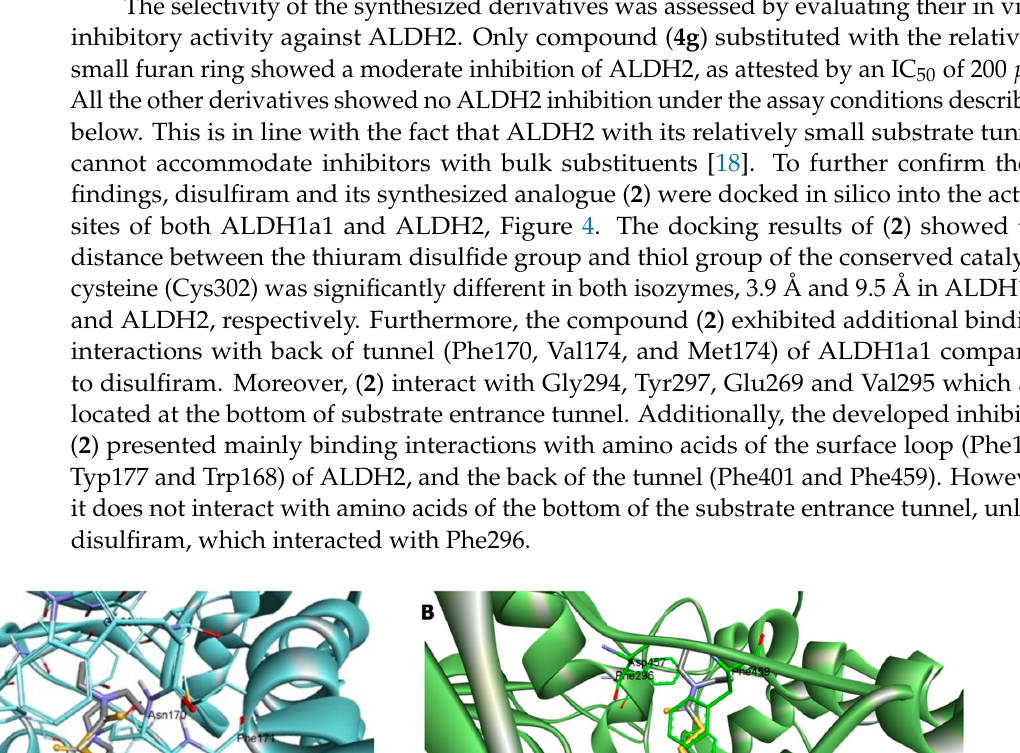
Solvents (EtOH, DCM, MeOH, DMF, chloroforme, toluene, and water), minerals (MgSO 4 and CaCl 2 ) were purchased from Carlo Erba Reagents (Dacit Group). All other chemicals were mainly purchased from Alfa Aesar (Karlsruhe, Germany), Merck (Sigma Aldrich) and TCI Europe (Boerenveldseweg, Belgium) or other commercial sources and used without further purification. Analytical thin layer chromatography (TLC) was per- formed with Nacherey Nagel (Polygram SILG/UV254) plates. Compounds were visual- ized by exposure to UV light or by dipping the plates in solutions of ninhydrin or potas- sium permanganate followed by heating. Flash column chromatography was performed with silica gel 60 (Acros Organics, Belgium). NMR spectra were recorded on BRUKER Avance III 400 MHz spectrometer in the indicated solvent. 1 H-and 13 C-NMR chemical shifts ( δ ) are quoted in parts per million (ppm) relative to the TMS scale. Coupling con- stants J are quoted in Hz. The following abbreviations are used for the proton spectra multiplicities: s: singlet, d: doublet, t: triplet, q: quartet, qt: quintuplet, sp: septuplet, m: multiplet, br.: broad, dd: double doublet, dt: double triplet. Coupling constants ( J ) are re- ported in Hertz (Hz). Infrared spectra were run on a Shimadzu IR Affinity spectropho- tometer coupled to a diamond ATR. High Resolution Mass Spectrometry (HRMS) was carried out on a Waters LCT Premier Time of Flight mass spectrometer using a Waters Acquity BEH C18 column (50 mm × 2.1 mm, 1.7 μ m). HPLC separation was performed at 600 μ L/min with an A/B gradient (A: water and B: CH 3 CN) using the following gradients: A (98%)/B(2%) to A (0%)/B(100%) in four minutes. This ratio was hold 1.3 min. before returning to initial conditions in 0.5 min. Mass spectra were obtained by electrospray ion- ization (ESI) in positive ionization mode detection. For all products, the parent ions cor- responded to [M + H] + . The purities of all tested compounds were analyzed by HPLC, the purities being all above 95 %. Analyses were performed using a VARIAN Pro Star Module with a column X Bridge C18 (5m/4.6 × 50 mm) using the following isocratic eluent: Water